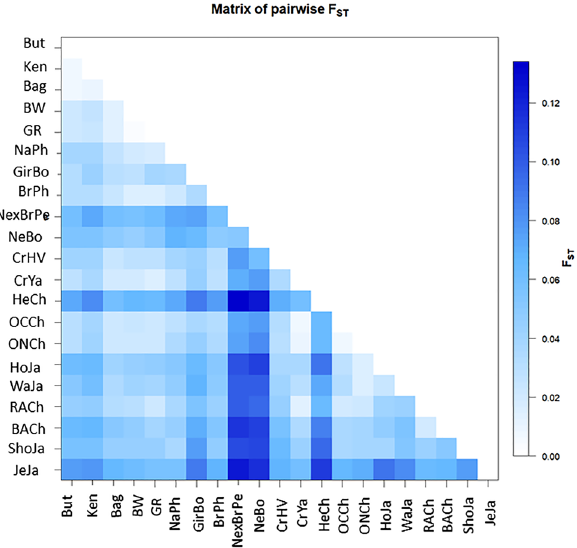
Figure 5. Graphic representation of calculated F ST between population pairs using an R package pairFstMatrix.r. But = Butana, Ken = Kename, Bag = Baggara, BW = Pyer Sein. GR = Shwe Ni, NaPh = Philippine native, GirBo = Bolivian Gir, BrPh = Philippine Brahman, BrxNePe = Peruvian Brahman × Nellore crossbreed, NeBo = Bolivian Nellore, CrHV = Creole Hatón del Valle, CrYa = Creole Yacumeño, HeCh = Chilean Hereford, OCCh = Chilean Overo Colorado, ONCh = Chilean Overo Negro, HoJa = Japanese Holstein, WaJa = Japanese Black, BACh = Chilean Black Angus, RACh = Chilean Red Angus, ShJa = Japanese Shorthorn and JeJa = Japanese Jersey.